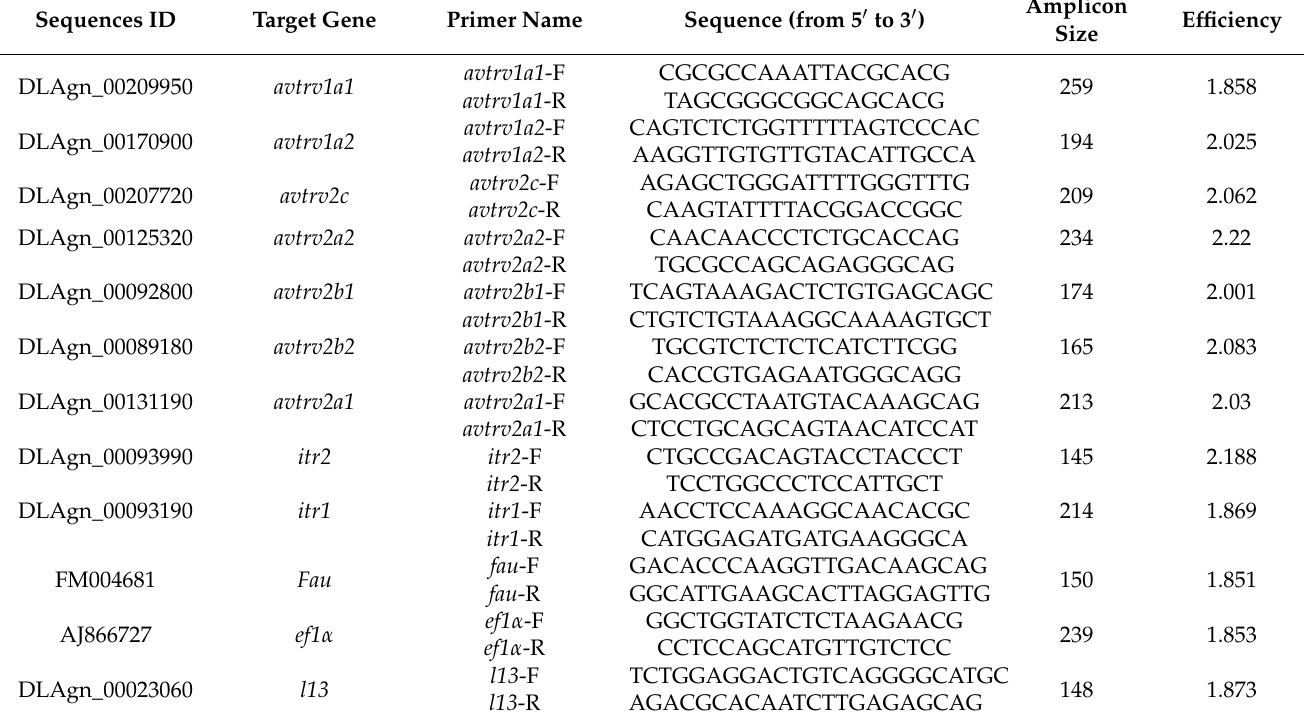
Table 1. Primer sequences used for qPCR in this study. F: forward primer; R: reverse primer. Sequences ID indicate gene sequences from the sea bass genome or Genbank identification numbers when